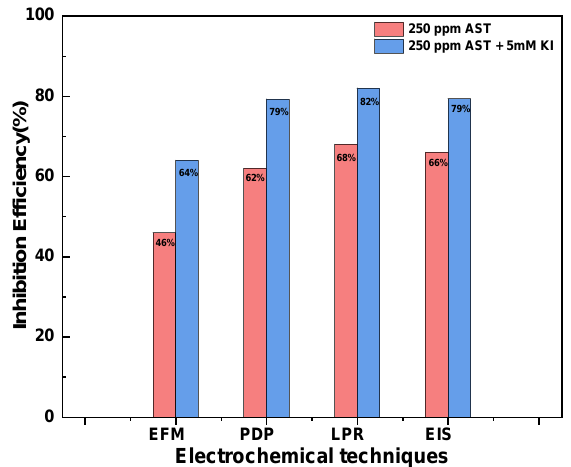
Figure 8. Comparison of the Inhibition e ffi ciencies obtained from the di ff erent electrochemical techniques: EFM, LPR, PDP and EIS with 250 ppm AST and 250 ppm AST + 5 mM